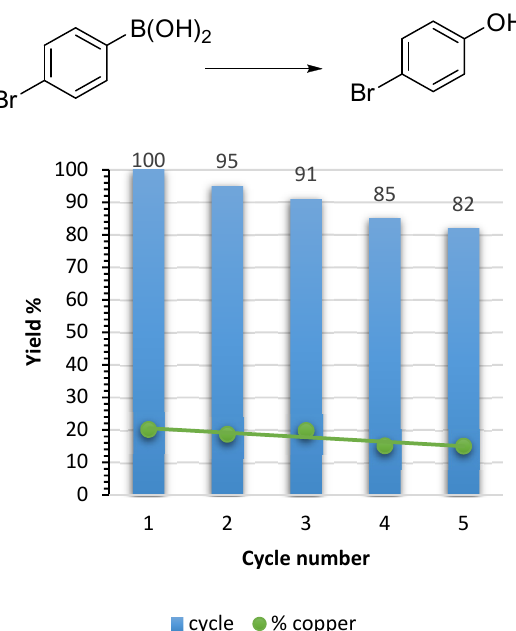
Figure 7. The evolution of catalytic process efficiency and CEDA-[Cu] reuse.